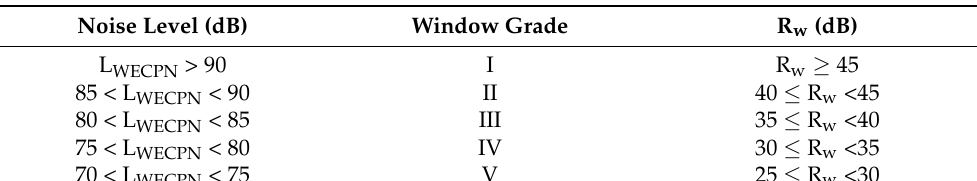
Table 7. Selection of the sound insulation window for sensitive buildings under different aircraft noise levels [39,40]. R w is the weighted sound reduction index.